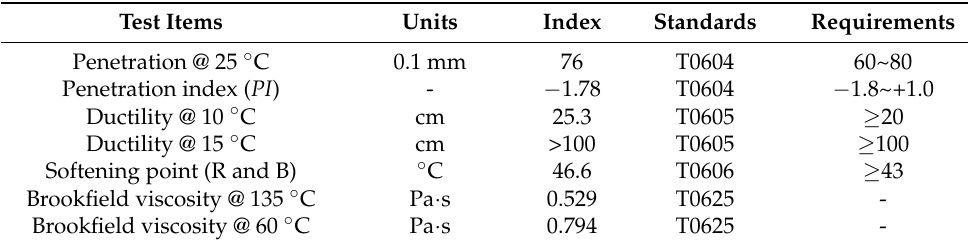
Table 1. Basic performance parameters of AH-70 asphalt.